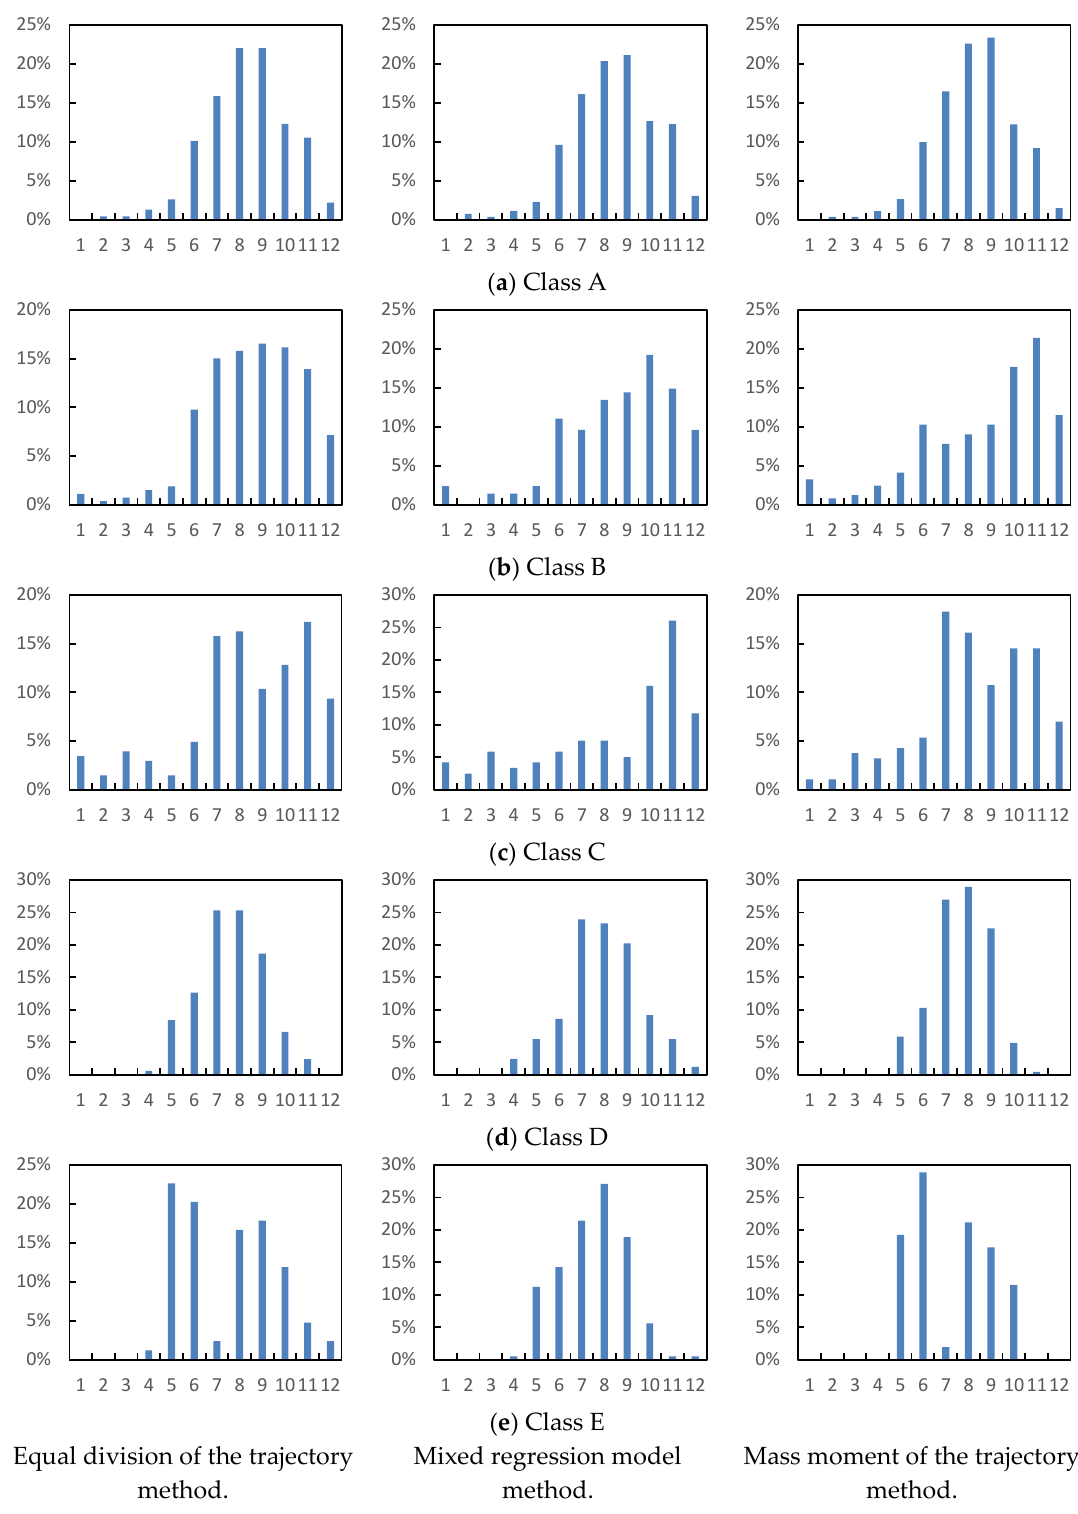
Figure 7. ( a – e ) Seasonal distributions of TCs in different classes according to the different trajectory clustering methods.